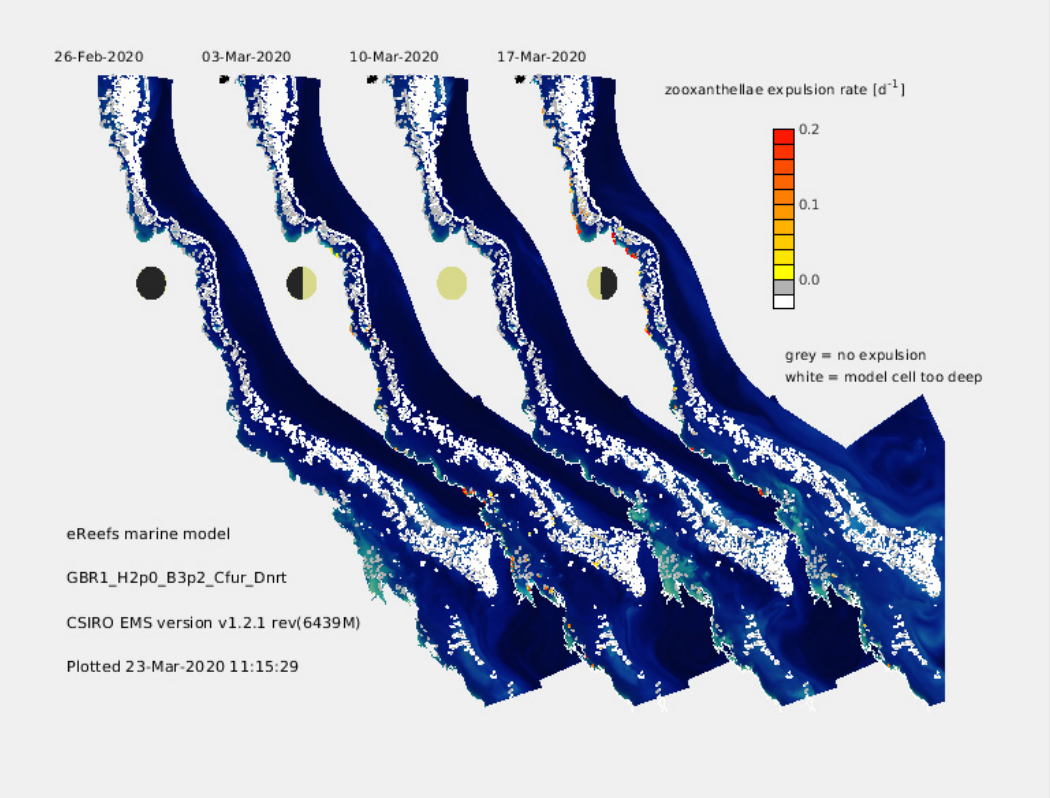
Figure 8. Water colour and zooxanthellae expulsion rate in coral polyps on the 26 February (new moon), 4 March (1st quarter), 10 March (full moon), and 17 March (3rd quarter), 2020, for the Great Barrier Reef. The water colour is the simulated true colour, a model-generated estimate of the colour of the ocean as seen from above, based on the normalised water leaving radiance of red, green, and blue light, that has been calculated considering the 20+ optically active constituents in the marine model [65]. The water looks greener due to suspended particles such as inorganic particulates and phytoplankton. Each model pixel with a reef community is assigned a colour and rendered on top of the true colour image. White is used to show reefs that are too deep (z > 20 m) in the 1 km resolution model to bleach. Grey shows pixels that are shallower than 20 m, but with reactive oxygen concentrations less than that initiated zooxanthellae expulsion. Yellow to red shows increasing rates of expulsion.